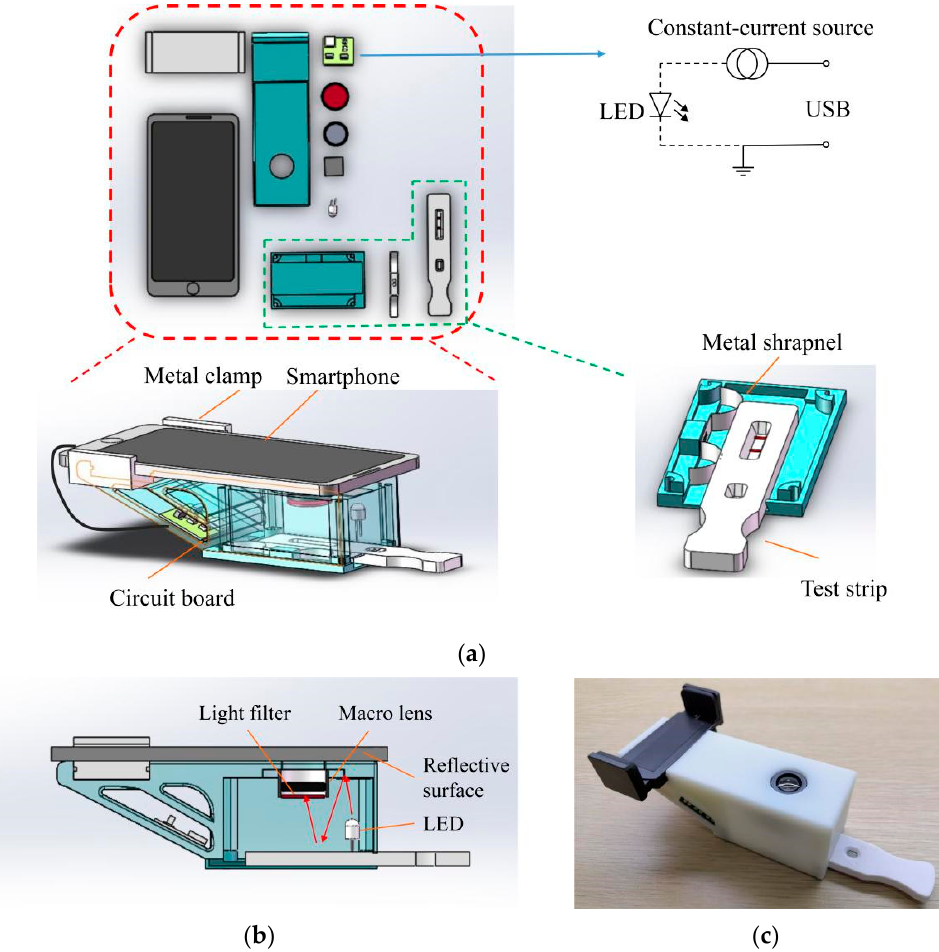
Figure 1. ( a ) Design diagram of the optical module; ( b ) Optical path of the optical module; ( c ) Physical diagram of the optical module.